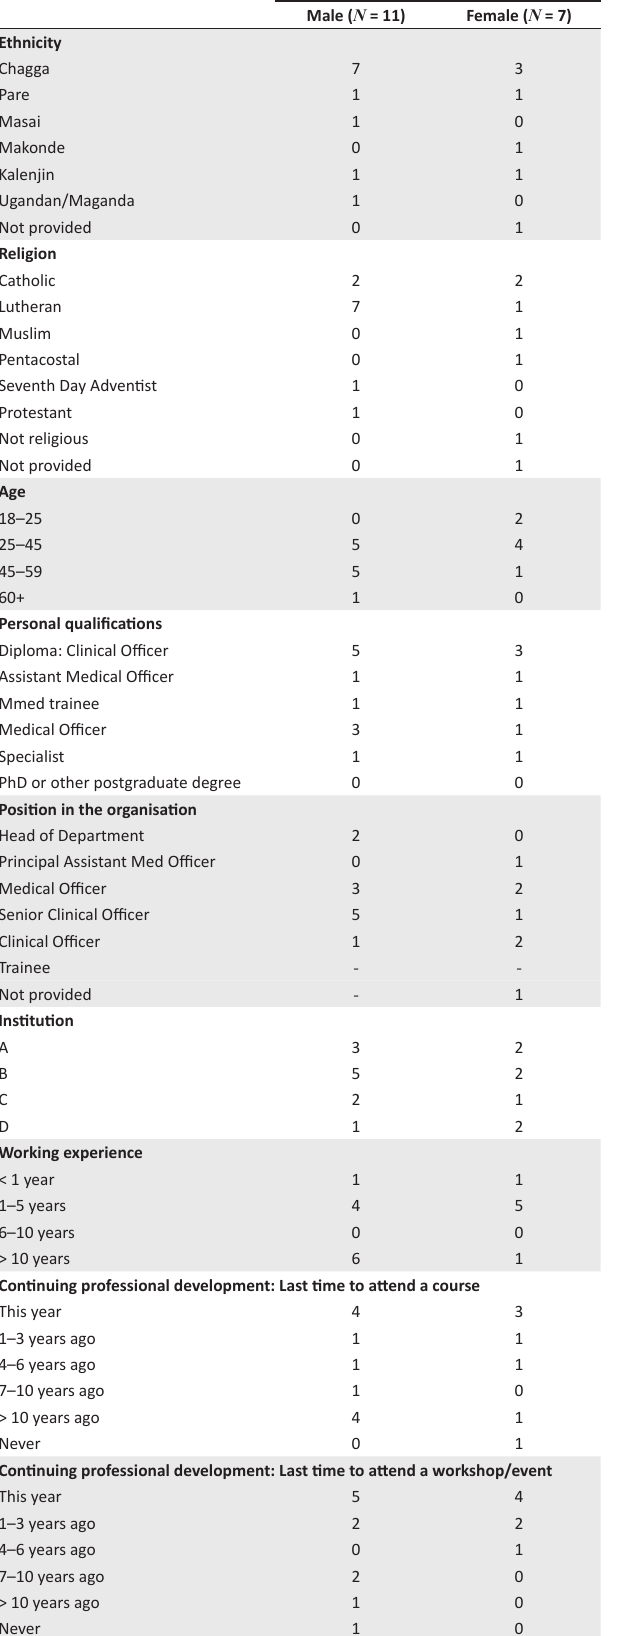
TABLE 2b: The demographic distribution related to the personal identities of the laboratory workers participating in this study. Demographic